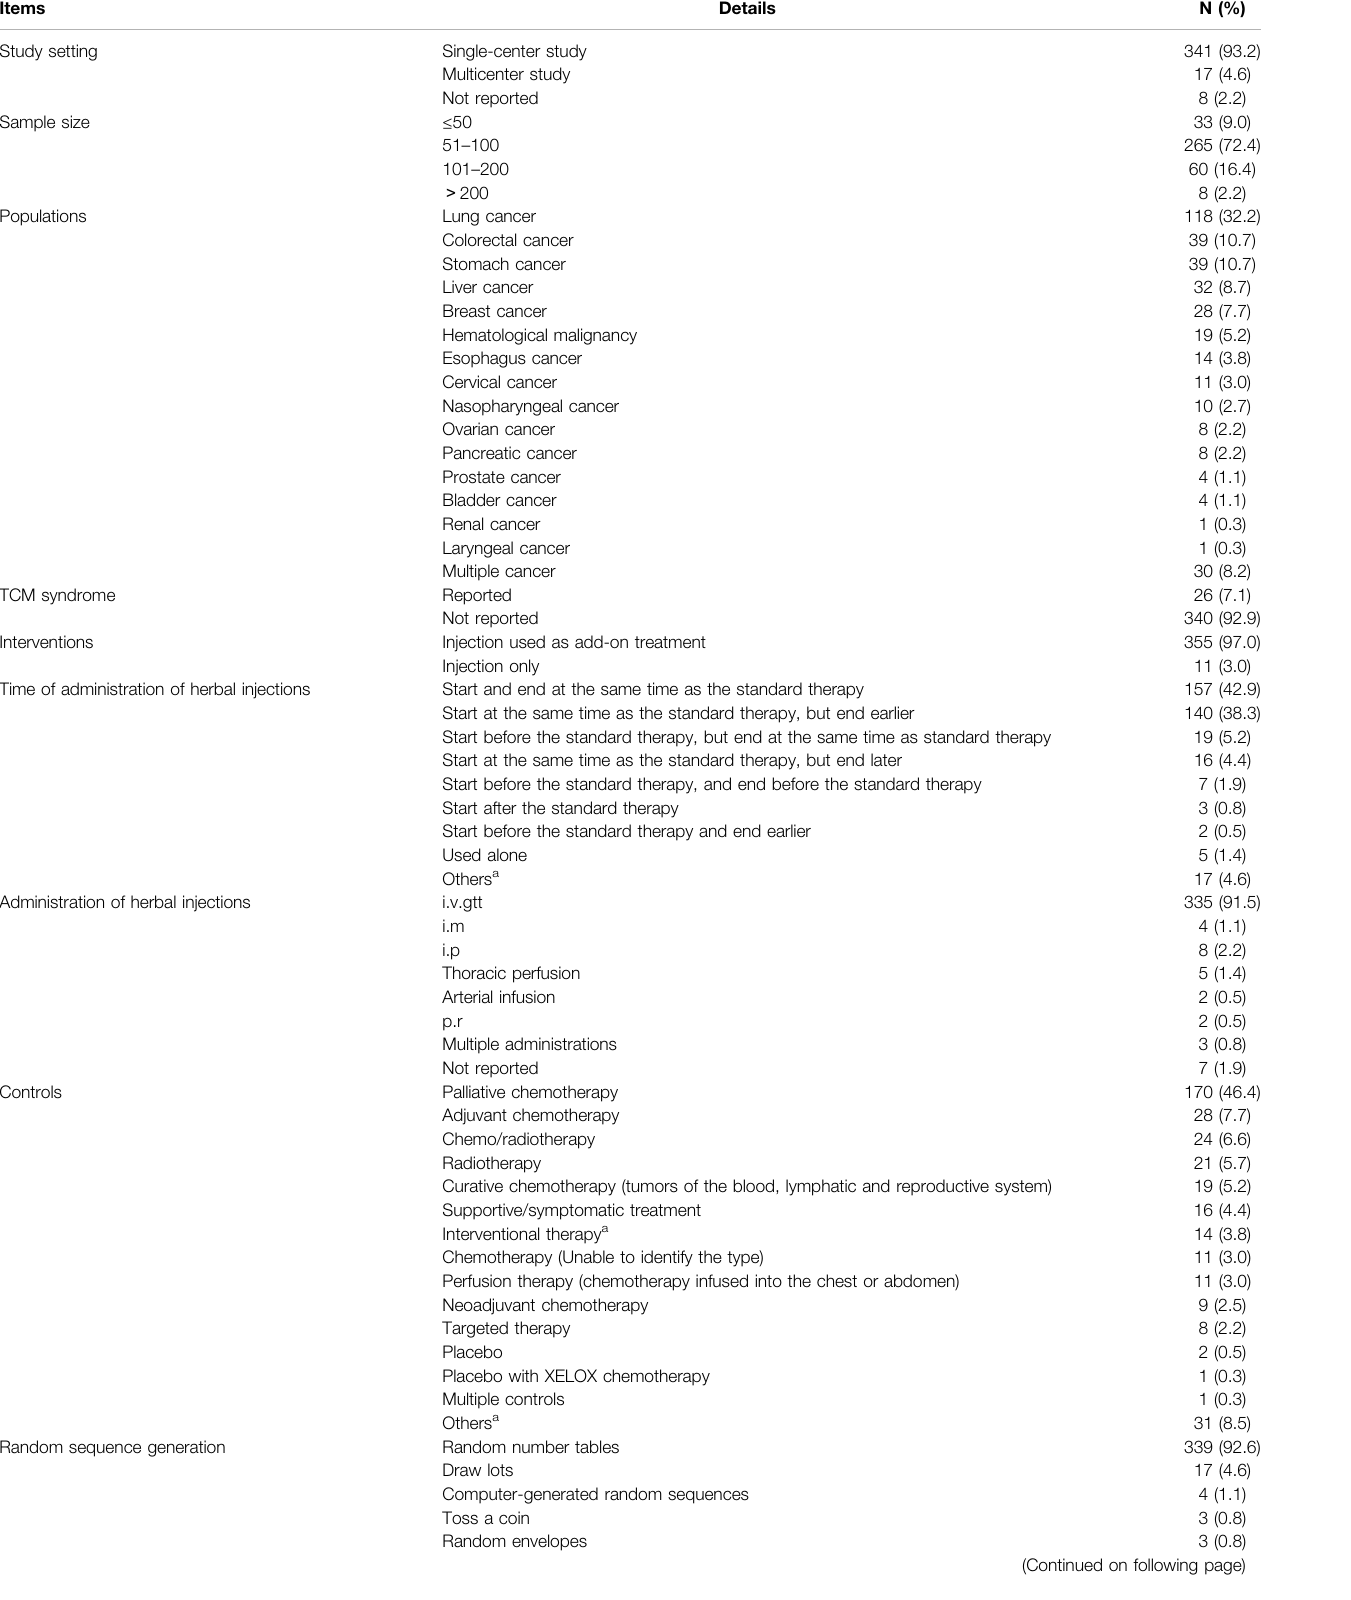
TABLE 4 | The clinical and methodological characteristics reported in the included RCTs of Chinese herbal injections for cancer care.